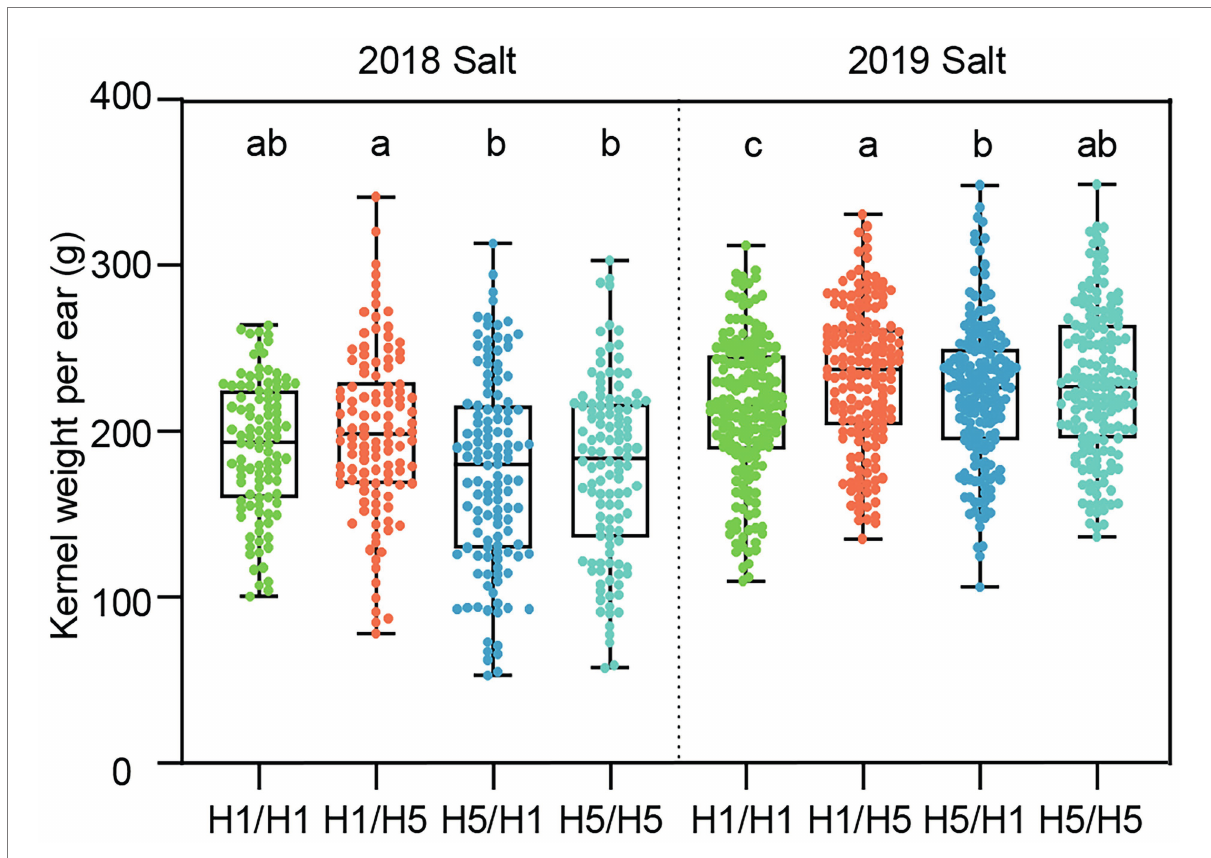
FIGURE 6 The yield-related traits of hybrids in 2018–2019 Ningxia under salt stress conditions. H1/H1, H1/H5, H5/H1, and H5/H5 are genotypes of four hybrids represent 83B28 H1 × A5302 H1 , 83B28 H1 × A5302 H5 , 83B28 H5 × A5302 H1 , and 83B28 H5 × A5302 H5 , respectively. Boxes show mean and quartile, whiskers represent max to min. Different letters indicate significant differences among hybrids ( p < 0.05, one-way ANOVA, Duncan’s test, and Tamhane’s